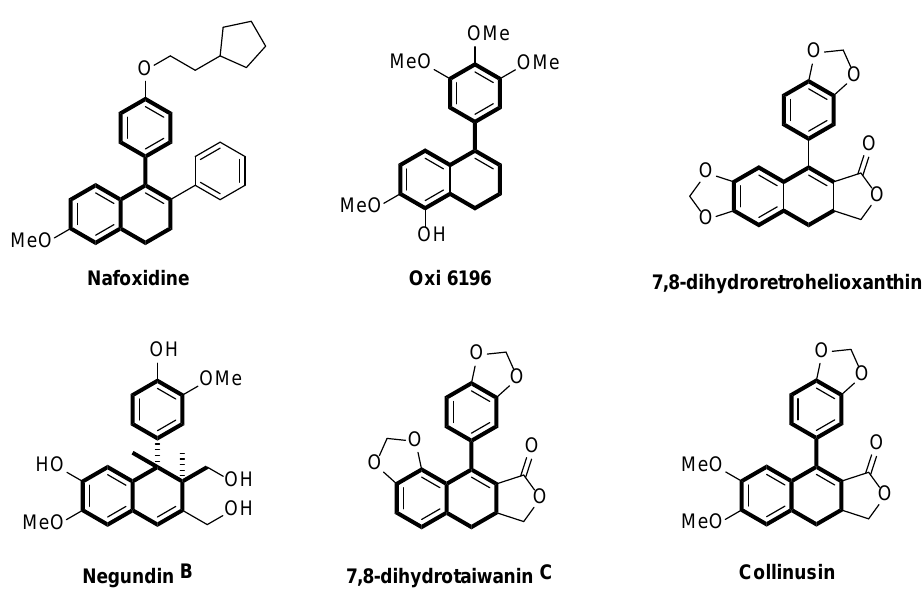
Figure 1. Representative natural products and bioactive compounds containing aryldihydronaphthalene structures [3–7].